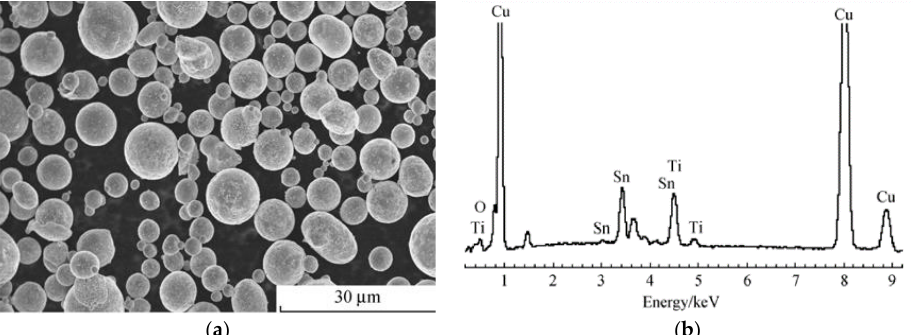
Figure 4. ( a ) SEM photograph; ( b ) EDS spectrum of Cu 10 Sn 5 Ti brazing filler metal powder [16]. Reproduced with permission from Journal of the Chinese Ceramic Society, 2011.